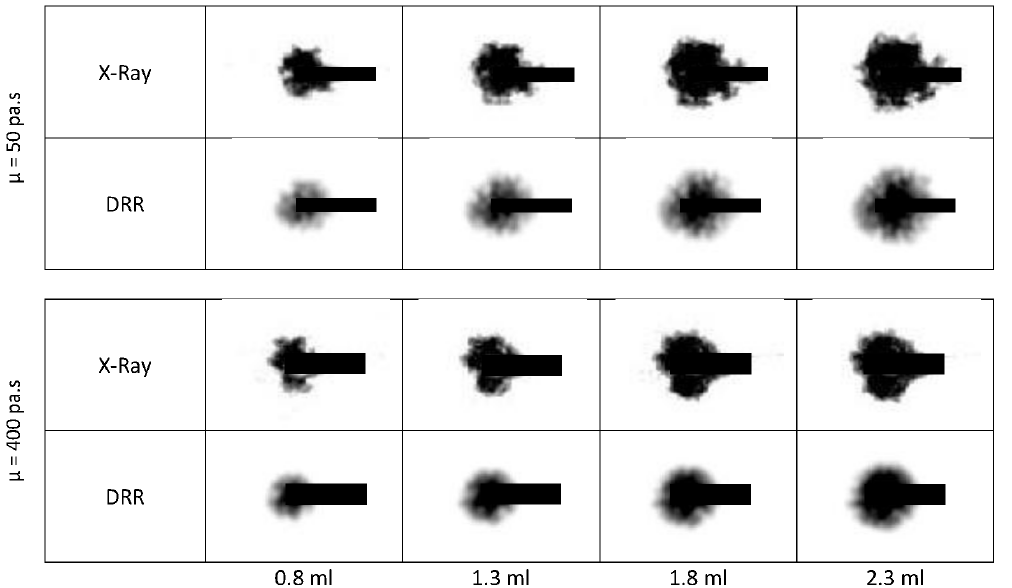
Figure 12. Segmented X-ray snapshots and the corresponding segmented DRR images for two extreme viscosity injections. The dark lines represent the